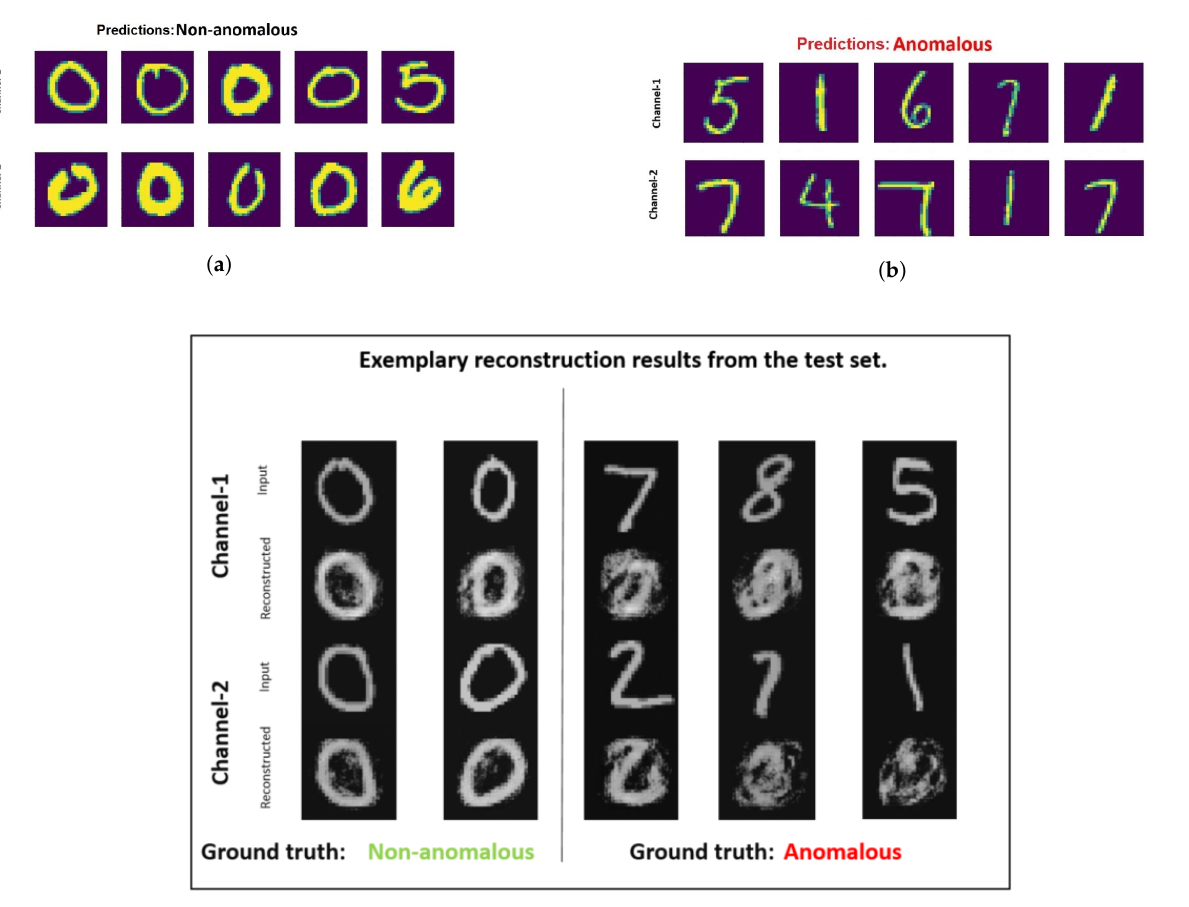
Figure 5. Most normal ( a ) and most anomalous ( b ) samples determined by multi-perspective denoising fusion technique for multi-perspective MNIST [9] dataset. In this dataset, samples representing zero are considered to be from non-anomalous class and other digits are considered to be from the anomalous class. ( c ) illustrates the reconstructed output for examples from the test